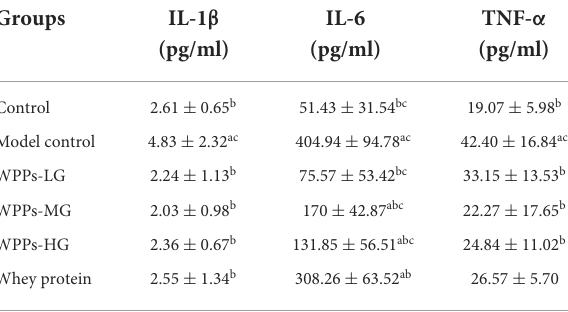
TABLE 3 Effects of WPPs on the inflammatory